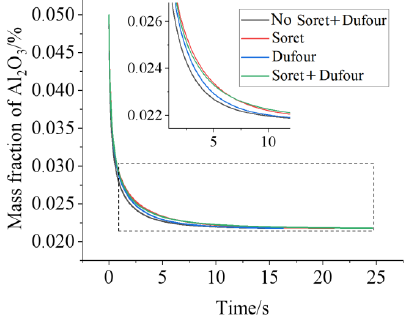
Figure 4. Comparisons of mass transfer for various cases, neither Soret effect nor Dufour effect, only the Soret effect, only the Dufour effect, both Dufour and Soret effects being in consideration. The temperature of heat sources is 350 K, the initial mass fraction of nanoparticle is 5 wt%.